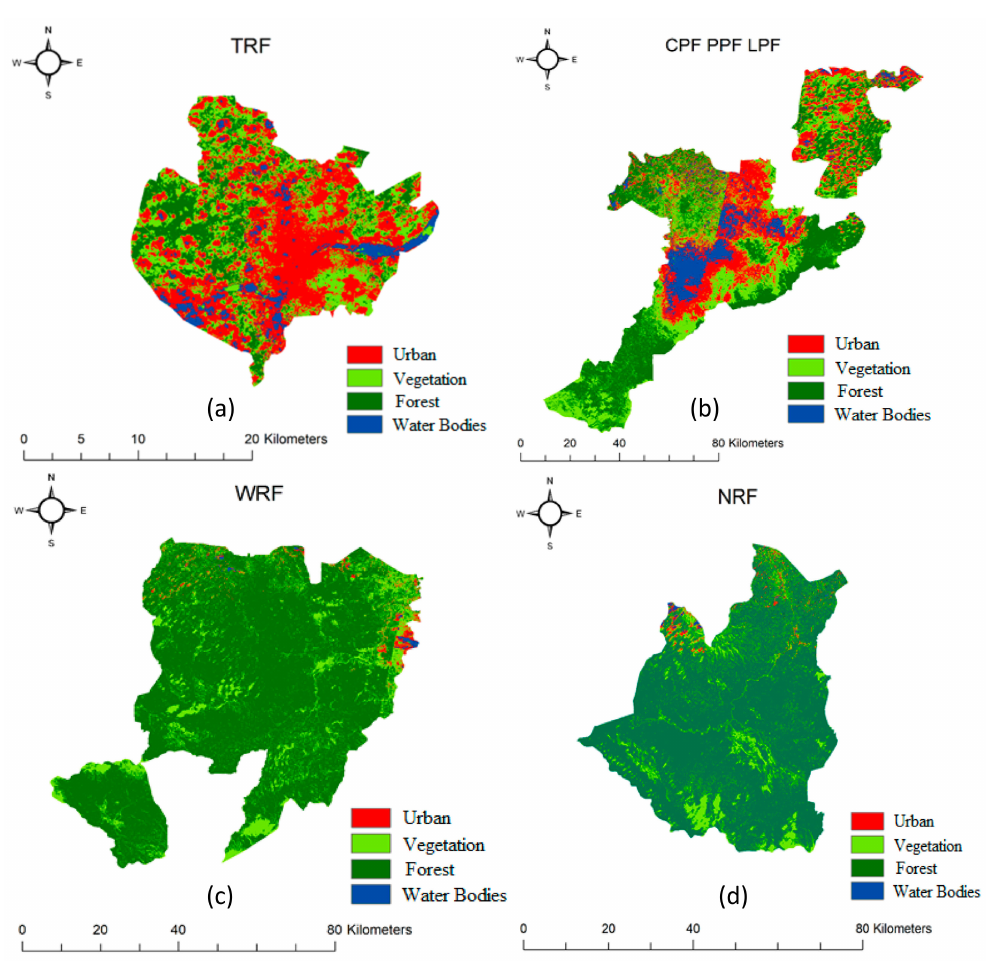
Figure 4. LULC for each type of forest: ( a ) TRF; ( b ) CPF, PPF and LPF; ( c ) WRF; and ( d )